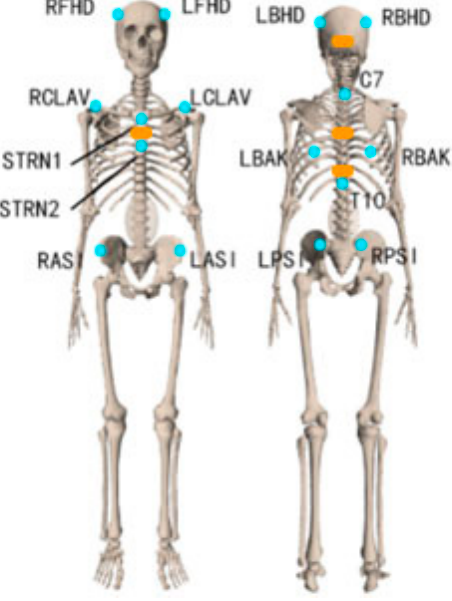
Figure 1. Marker (blue dots) & IMU (orange rectangles) placement.